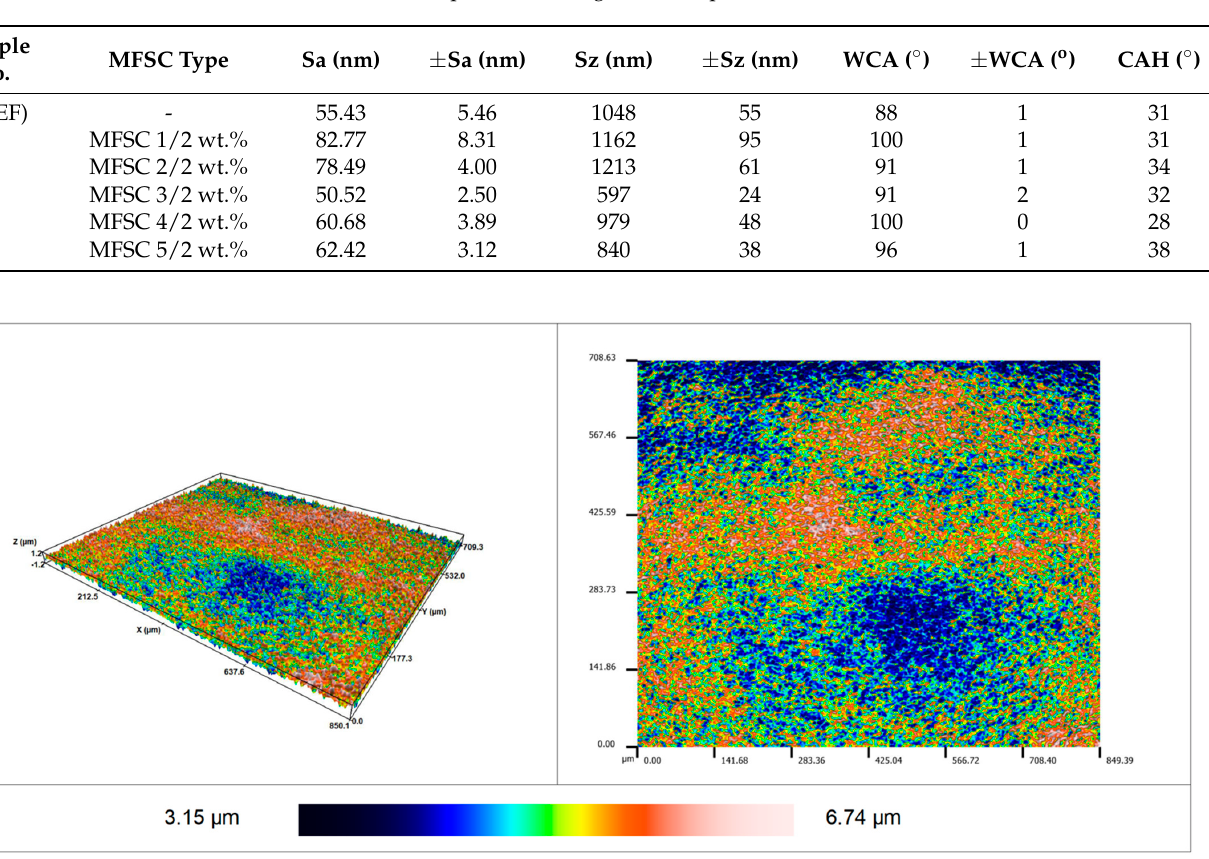
Figure 1. The visualization of the surface of the reference sample made with a